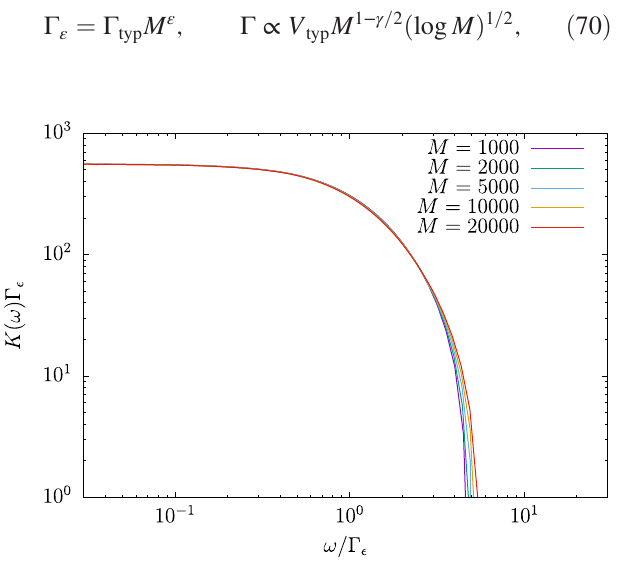
FIG. 13. We plot the rescaled overlap correlation function K ð ω Þ Γ ε vs ω = Γ ε , where Γ ε ¼ Γ typical miniband width and Σ 00 [Eq. (128)]. Different curves correspond to different values of M and collapse well with ε ¼ 0 . 05 . We use the ensemble of IB Hamiltonians with a dispersion of classical energies W ¼ λ V M γ = 2 , with γ ¼ 1 . 2 and λ ¼ 3 . 3 typ